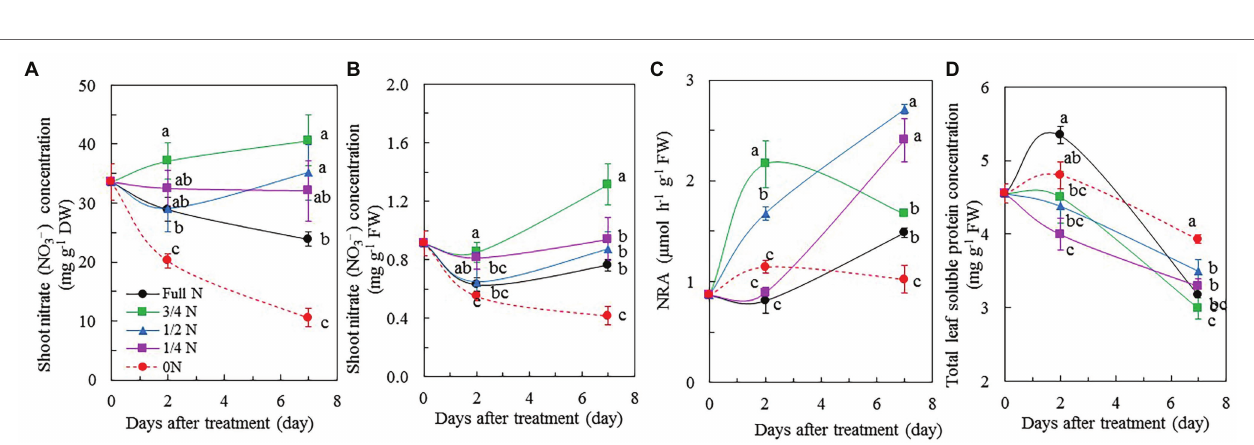
FIGURE 3 | Changes of leaf succulence (LS; A ), leaf dry matter accumulation (LDMC; B ), and leaf water content (LWC; C ) of M. crystallinum after different NO 3– treatments. Vertical bars represent the SEs. Means with different letters are statistically different ( p = 0.05; n = 5) as determined by LSD multiple comparison test.